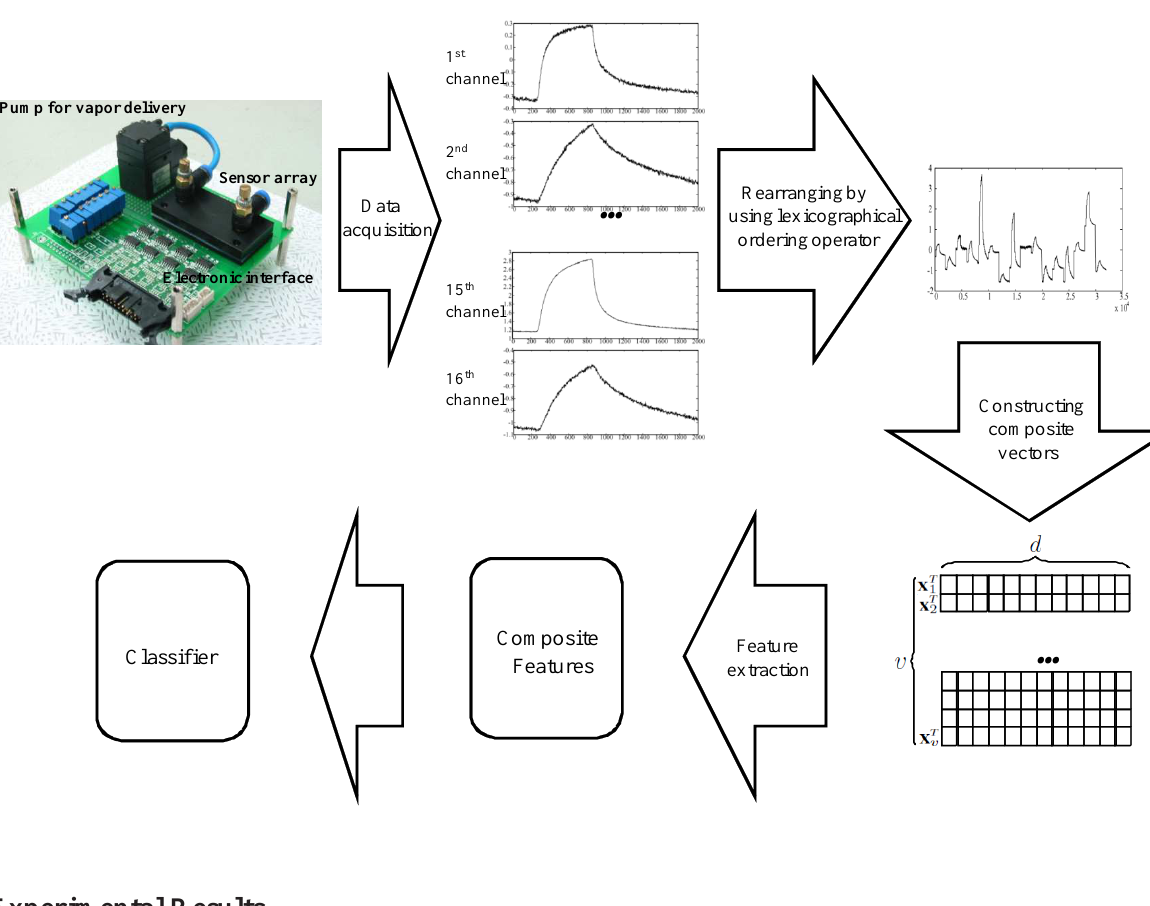
Figure 5. Overall procedure of the e-nose